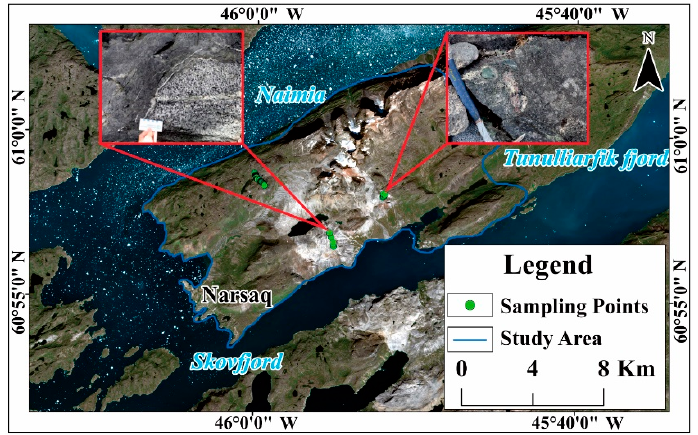
Figure 3. Distribution map of field spectral samples (the base image is a combination of the 432 bands of Sentinel-2).